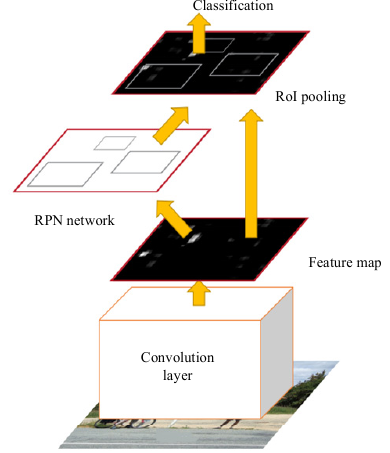
Figure 3. Faster R-CNN model structure.